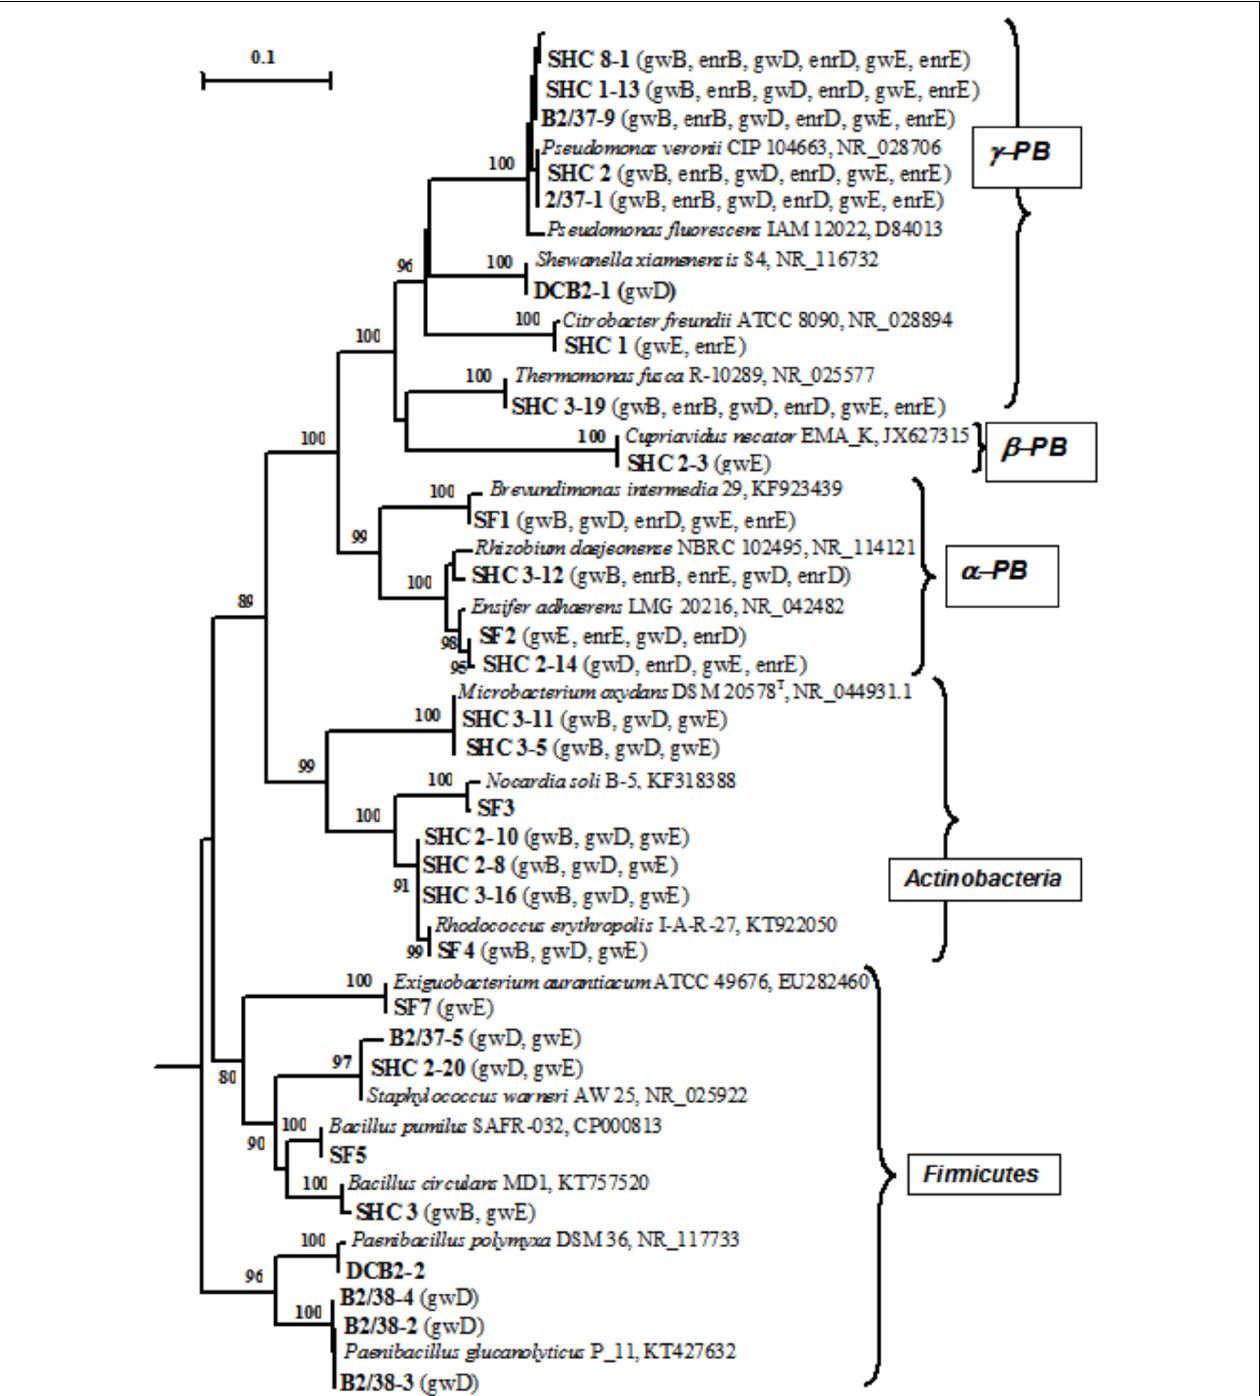
FIGURE 4 | Phylogenetic tree of the 16S rRNA genes of pure cultures isolated from groundwater (shown in boldface). The libraries containing the OTUs (phylotypes) closely related to the 16S rRNA genes of the isolates (over 98% similarity) are shown in parentheses. The scale shows the evolutionary distance corresponding to five nucleotide replacements per 100 nucleotides. The numerals indicate the branching order determined by bootstrap analysis of 100 alternative trees (the values above 80 were accepted as significant). Accession numbers of 16S rRNA genes of isolated strains are given in Supplementary Table S3 . α -PB , Alphaproteobacteria; β -PB , Betaproteobacteria, and γ -PB , Gammaproteobacteria.